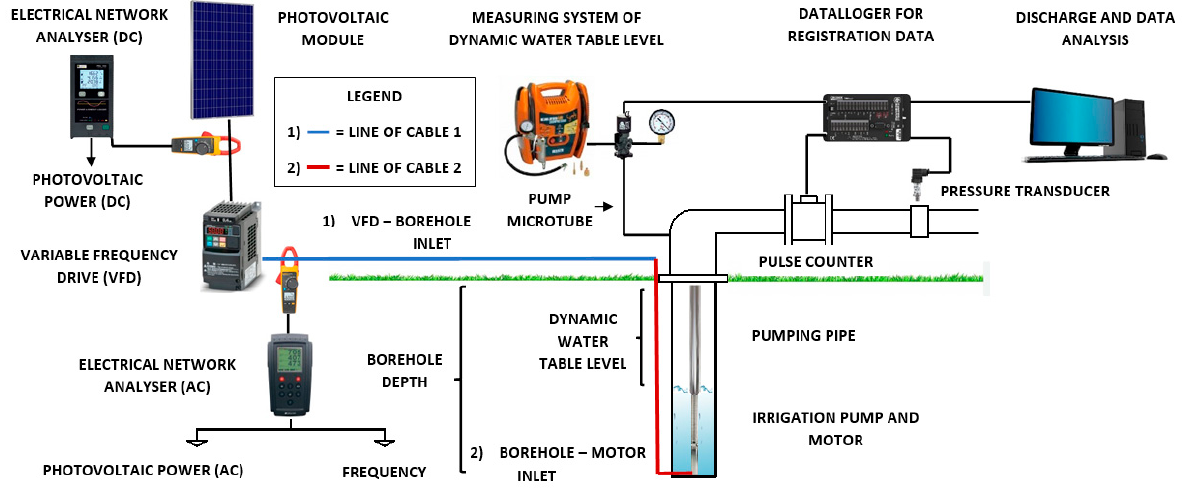
Figure 1. Scheme of the measurement devices for the monitoring of the pumping system.